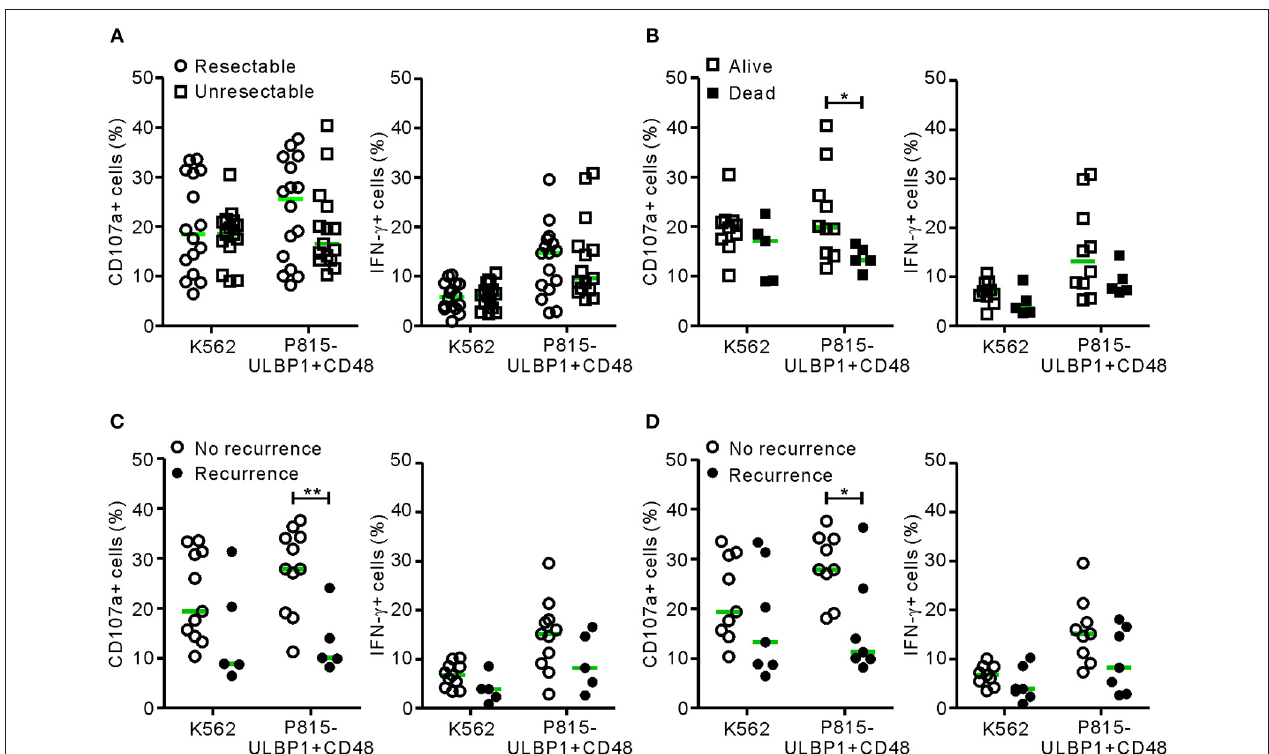
FIGURE 3 | NK cell dysfunction correlates with clinical outcome in PC. (A) The malignant group was divided into resectable and unresectable subgroups. PBMCs from the resectable group ( n = 16) and the unresectable group ( n = 15) were incubated with or without the indicated target cells, as described in Figure 1 (circle, resectable; square, unresectable). In each group, NK cell surface expression of CD107a and intracellular expression of IFN- γ were compared. (B) The unresectable group was subdivided into living ( n = 10) or deceased ( n = 5) patients at 6 months after diagnosis. The NK cell activity of each subgroup was compared. (C) The resectable group was subdivided into patients with ( n = 11) or without ( n = 5) recurrence at 6 months after surgical resection. The NK cell activity of each subgroup was compared. (D) The resectable group was subdivided into patients with ( n = 9) or without ( n = 7) recurrence at 12 months after surgical resection. Horizontal bars (green) indicate the medians. * P < 0.05 and ** P < 0.01; Mann-Whitney U